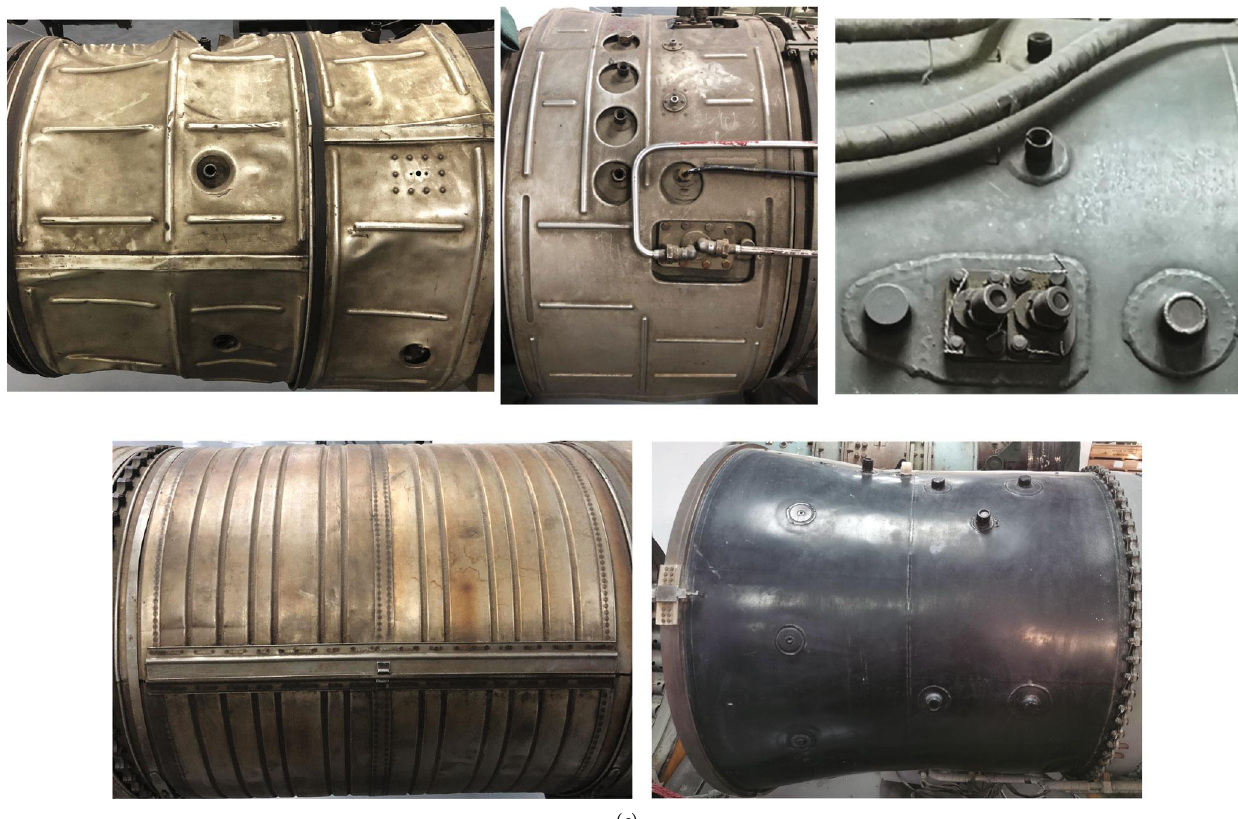
Figure 4: The shape characteristics of aero-engine pro fi le point cloud (a) complex and irregular shape (b) rich detail features (c) irregular distribution.